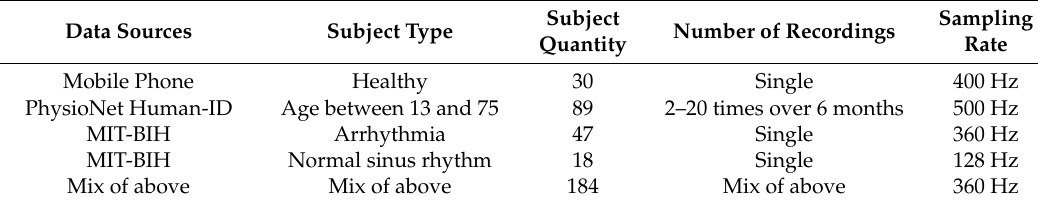
Table 1. Summary of the datasets used in this study. MIT-BIH: MIT-Beth Israel